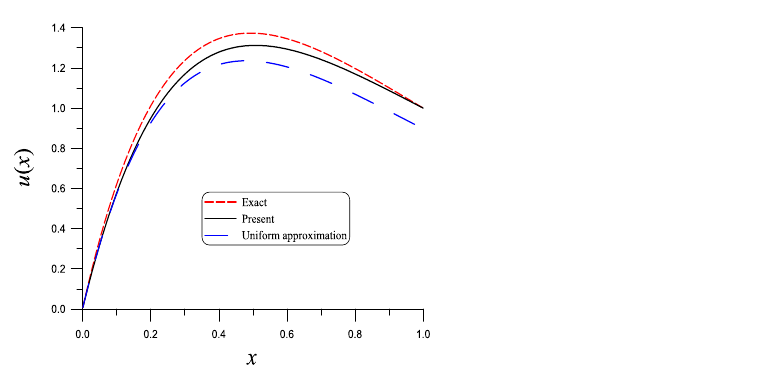
Figure 1. For a given example, comparing the exact solution, a uniform approximation and the present